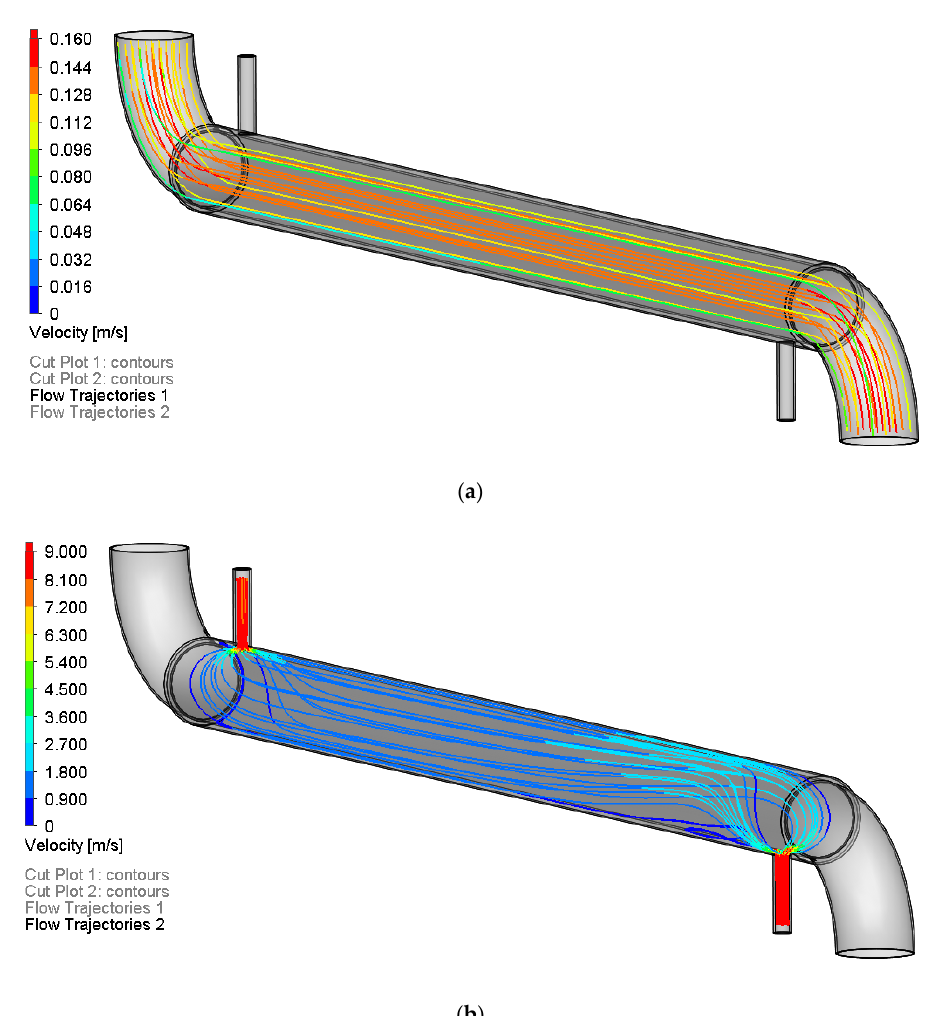
Figure 6. Path lines and velocity values at paste flow rate of 3000 kg/h, ( a ) of olive paste, ( b ) water. Figure 7a shows the shear rate, which decrease moving through the center of the tube, since the velocity variation between the fluid layers at the center is lower than that near the wall. As a consequence, the dynamic viscosity distribution increases at the center due to the pseudoplastic behavior (viscosity increases when the shear rate decreases), as shown in Figure